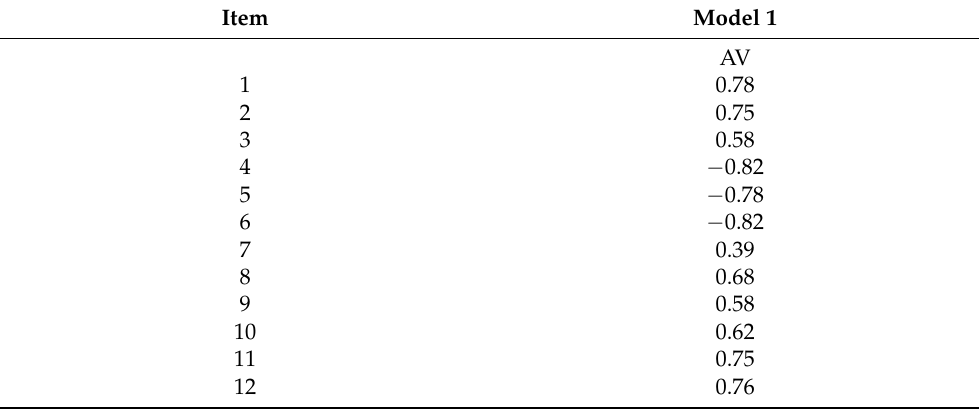
Table 2. Standardized solution in Model